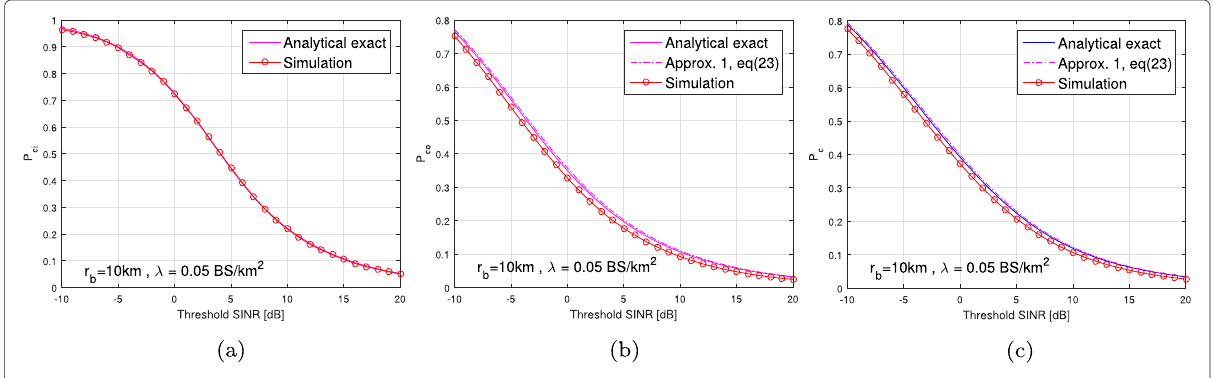
Fig. 6 CCDF of probability of coverage P c for dedicated spectra scenario. a Inside users P c / i b Outside users P c / o c General user P